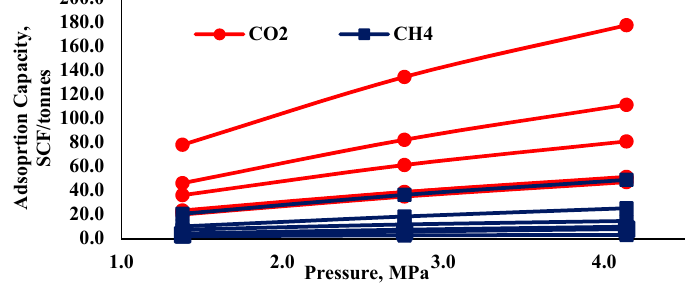
ff erent pressures